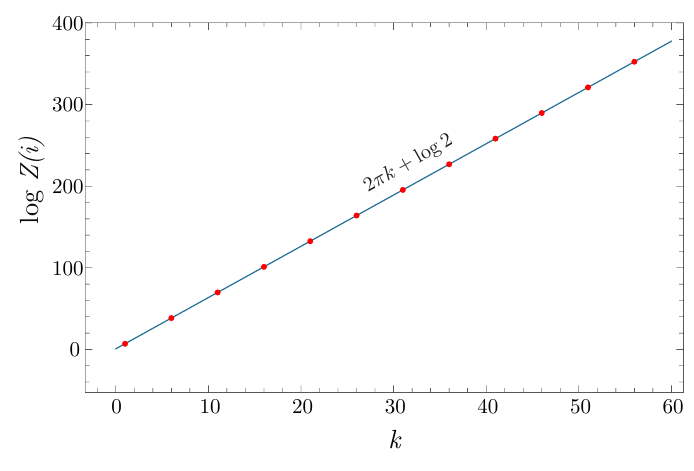
Figure 3 . Verifying log Z ( i ) (cid:24) = 2 (cid:25)k + log